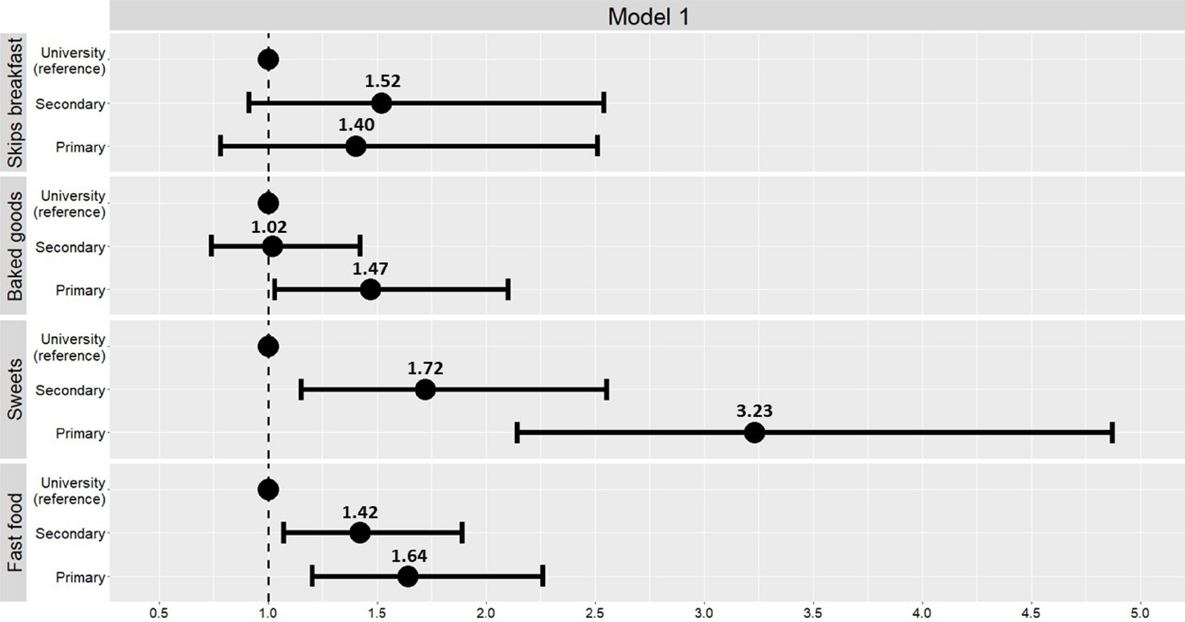
Figure 1. Association of maternal education with children’s having unhealthy dietary habits. Model 1. Multiple logistic regression models adjusted for sex, age, zBMI, municipality, school, and alloca- tion to intervention or control group. Model 2. Multiple logistic regression models adjusted for sex, age, zBMI, municipality, school, allocation to intervention or control group, and the corresponding dietary behavior at baseline. Skips breakfast (no = 0, yes = 1), has commercially baked goods or pastries for breakfast (no = 0, yes = 1), takes sweets and candies several times every day (no = 0, yes = 1), goes more than once a week to a fast-food restaurant (no = 0, yes = 1).